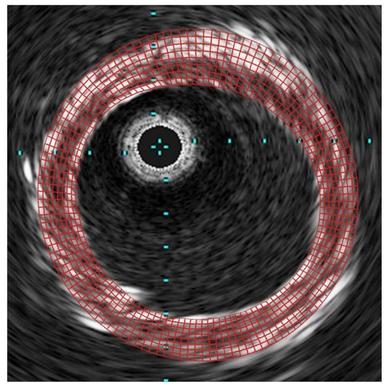
A representative overlay of the finite element mesh from Case 1 on the corresponding IVUS DICOM slice at 200 MPa.